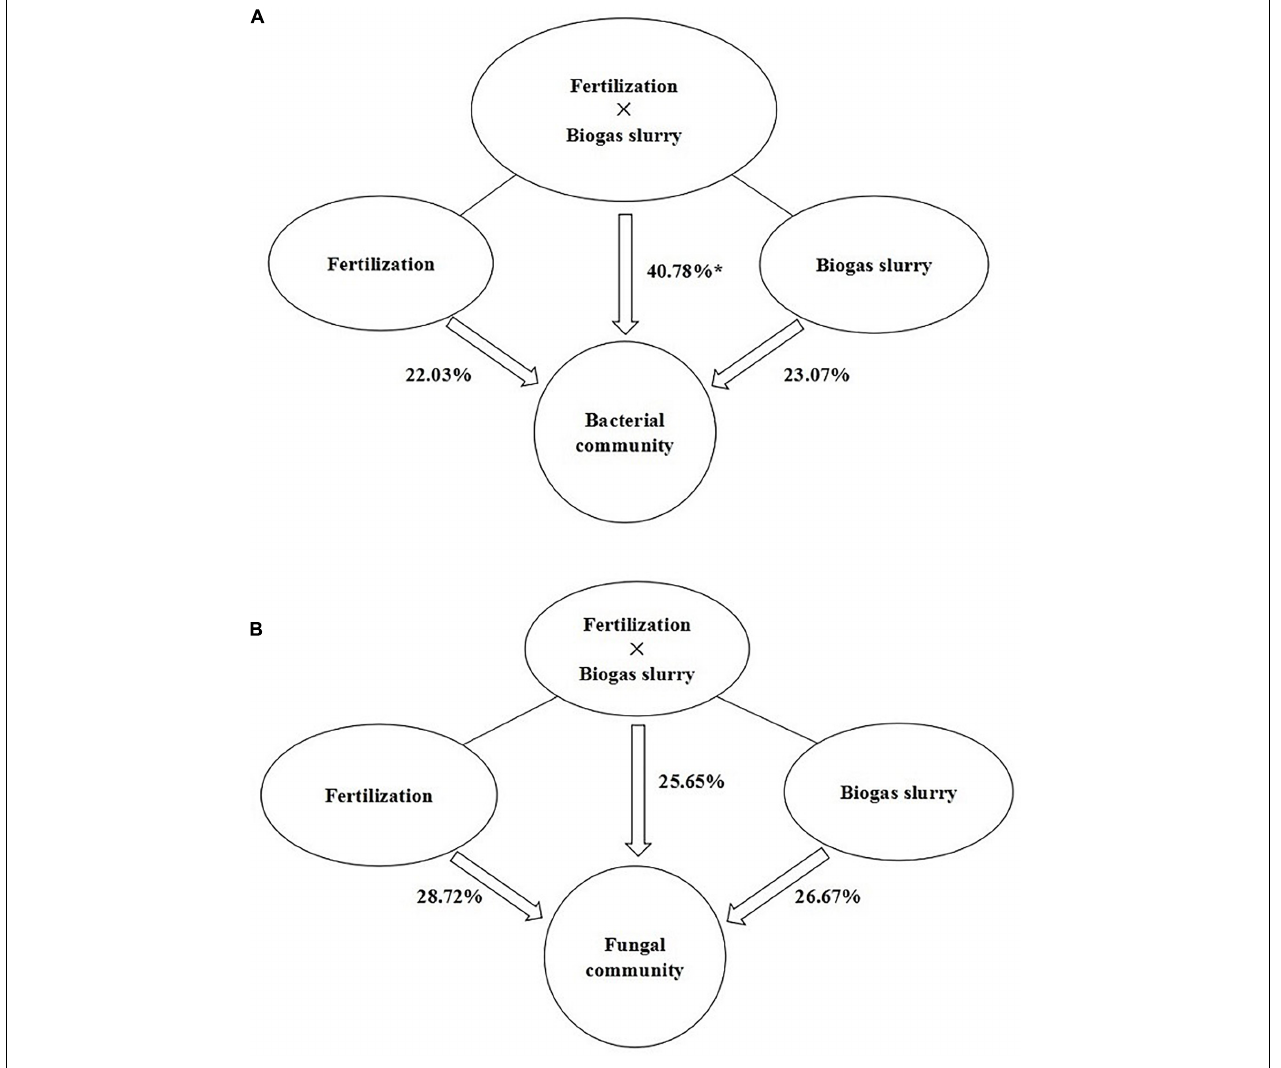
FIGURE 5 | PERMANOVA of the contributions of the application of fertilizer, biogas slurry and fertilizer × biogas slurry to the variation in bacterial (A) and fungal (B) community compositions. * represents significant differences at P <